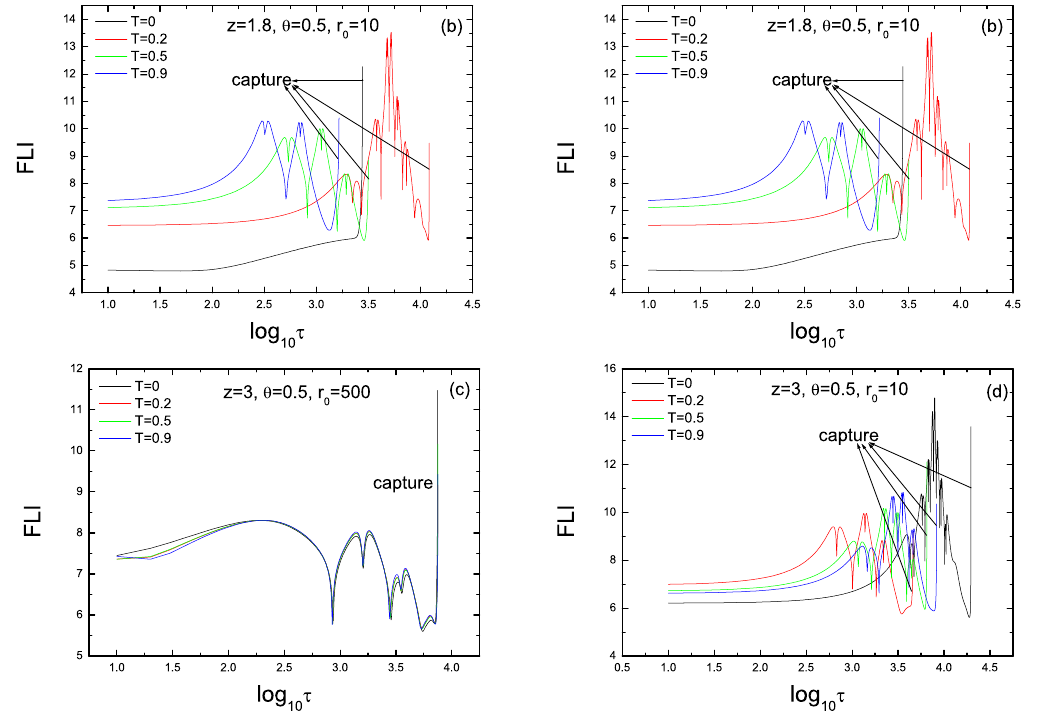
Figure 8 . FLIs with di(cid:11)erent z , (cid:18) and T for r 0 = 500 and r 0 =